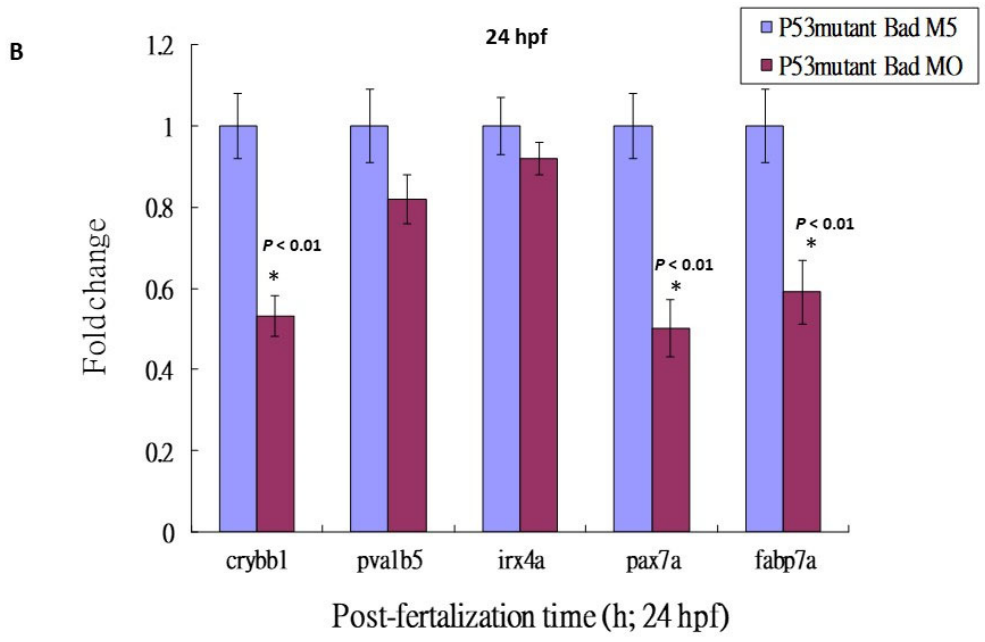
Figure 5. The identification of brain development-related genes was downregulated, but suppressed in the p53 mutant lines with Bad knockdown. ( A ) Identification of downstream brain development- related genes such as crybb1 , pvalb5 , irx4a , pax7a , and fabp7a in wild-type zebrafish by qRT-PCR at 24 hpf. All data were analyzed using either paired or unpaired Student’s t -tests, as appropriate. * p < 0.01. ( B ) Enhanced brain-development genes crybb1 , pvalb5 , irx4a , pax7a , and fabp7a in p53 mutant lines during Bad knockdown at 24 hpf, as shown by qRT-PCR. All data were analyzed using either paired or unpaired Student’s t -tests, as appropriate. * p < 0.01.